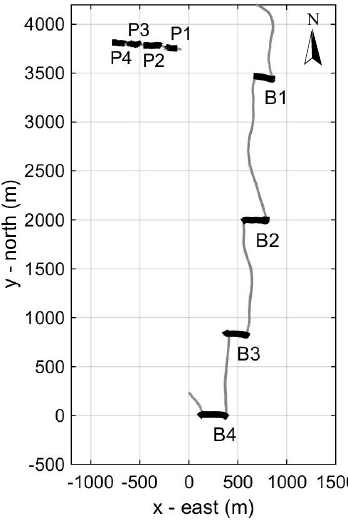
Figure 9. Vessel and buoy/pinger track on 6 June 2015—deep-water pinger localization experiment off Palaiochora. The area corresponds to rectangle “B” in Figure 3. The drifting vessel positions during stations B1–B4 and corresponding buoy/pinger locations (P1–P4) are marked by heavy lines.